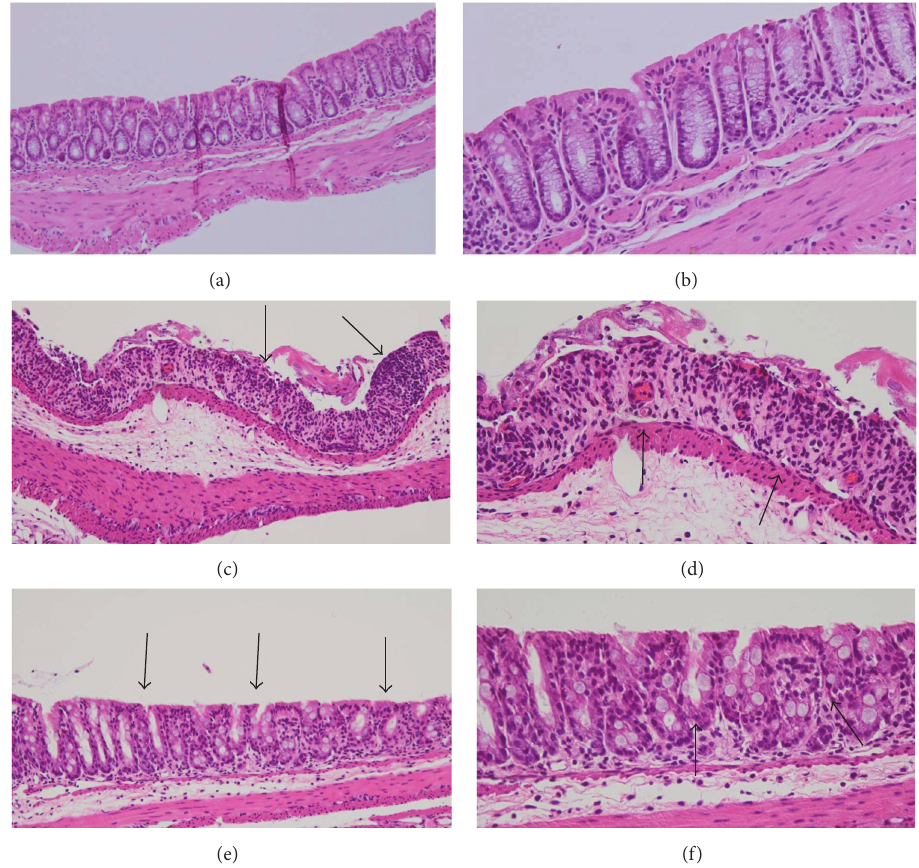
Figure 4: Histopathological analysis of hematoxylin and eosin-stained sections of the distal colon. (a, b) Untreated normal mouse: no disturbance of the ductal structure and no thickening of the wall. (c, d) Mouse provided with 5% dextran sulfate sodium (DSS) for 7 days: disturbance in the ductal structure and thickening of the wall (arrows) . (e, f) Mouse administered a combination of 5% DSS and daikenchuto: disturbance in the ductal structure and thickening of the wall, but milder than that in mouse provided with DSS alone (arrows) . Original magnification (a), (c), and (e): × 20; (b), (d), and (f): ×